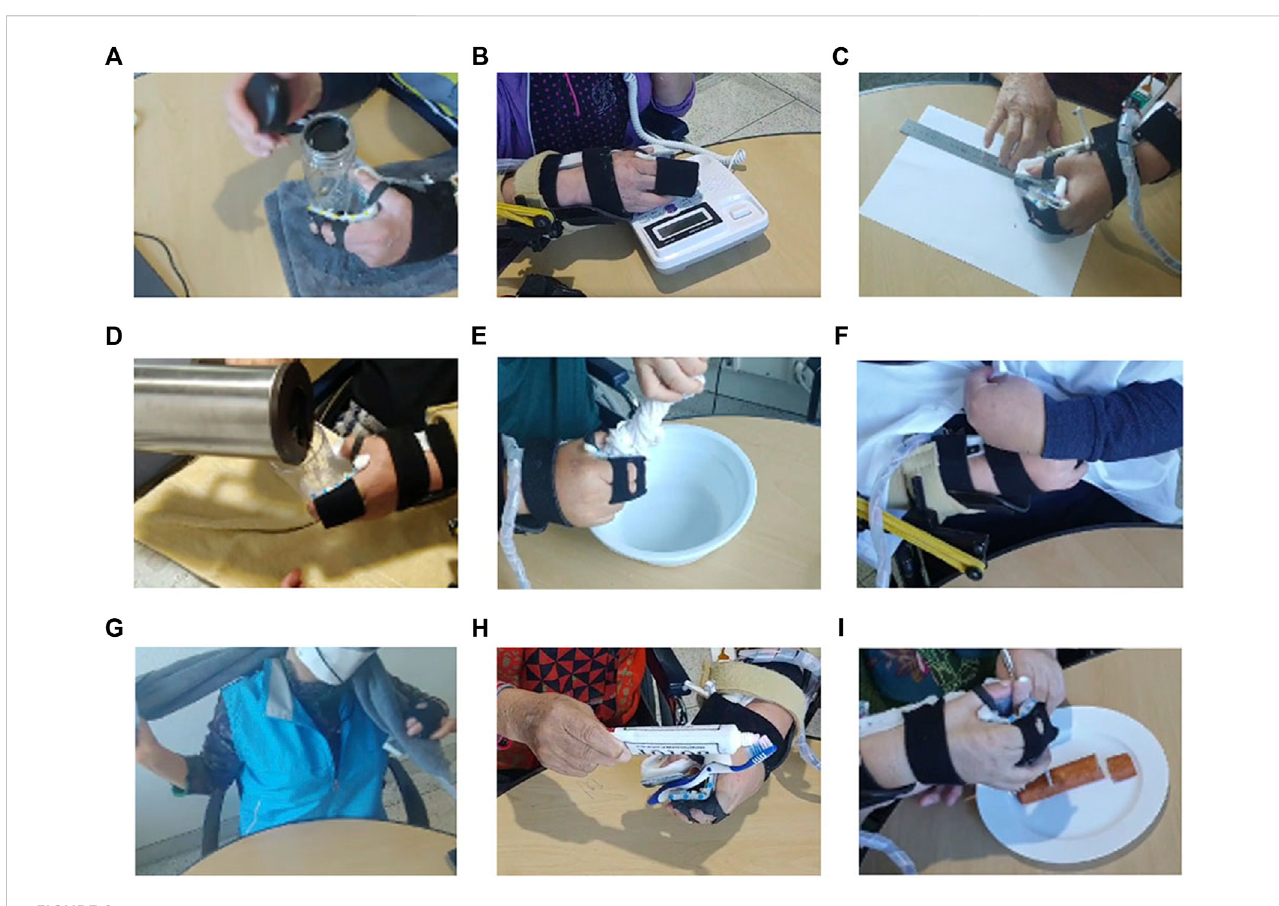
FIGURE 9 Tasks 1 – 9 from the Chedoke Arm Hand Activity Inventory (CAHAI)-9. (A) Task 1: Opening a jar of coffee. (B) Task 2: Dialing an emergency number. (C) Task3:Drawingalinewitharuler. (D) Task4:Pouringaglassofwater. (E) Task5:Wringingoutawashcloth. (F) Task6:fastening fi vebuttons, (G) Task7:Drying the back with a towel. (H) Task 8: Putting toothpaste on a toothbrush. (I) Task 9: Cutting medium-resistance